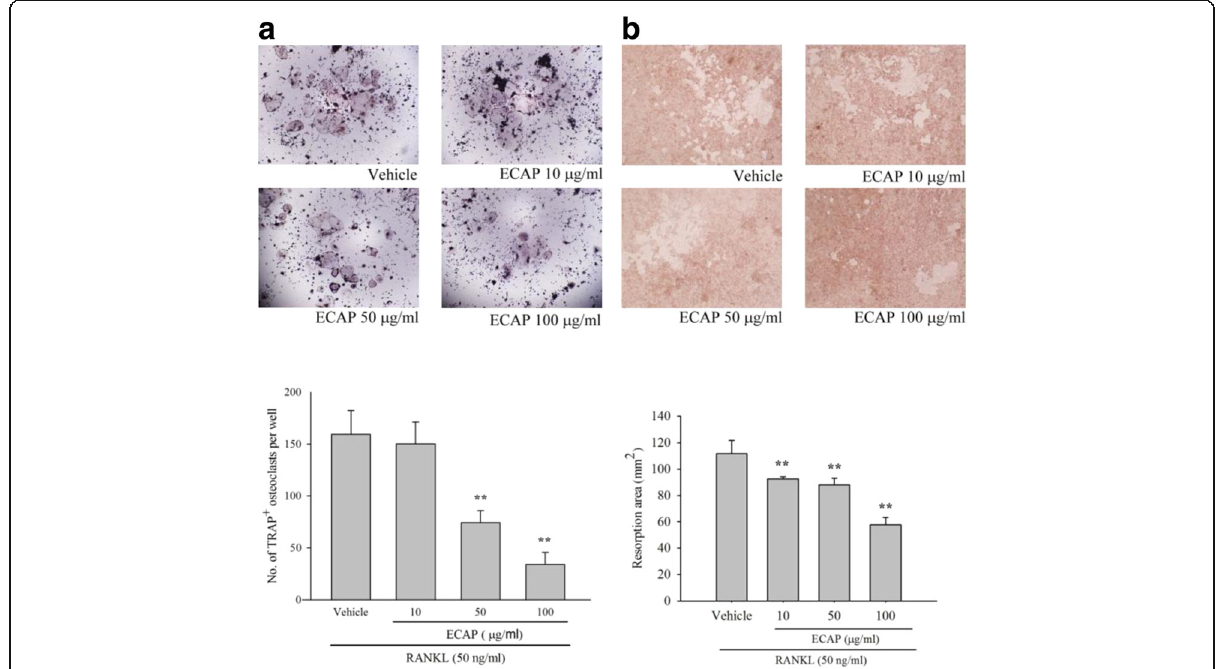
Fig. 2 Effects of ECAP on RANKL-induced osteoclastogenesis activity. a RAW 264.7 cells were cultured for 5 days in the presence of RANKL (50 ng/ml) with the vehicle (H 2 O) or ECAP. Multinucleated osteoclasts were visualized by TRAP staining. TRAP-positive cells were photographed under a light microscope. Multinucleated TRAP-positive cells with ≥ 3 nuclei were defined as osteoclasts. b RAW 264.7 cells were cultured on Osteoclast Activity Substrate plates in the presence of RANKL (50 ng/ml) with the vehicle (H 2 O) or ECAP for 7 days. After a 7-day culture, adherent cells were removed and photographed under a light microscope. Each value represents the mean ± SD. ( n = 3). ** P < 0.01 compared with RANKL